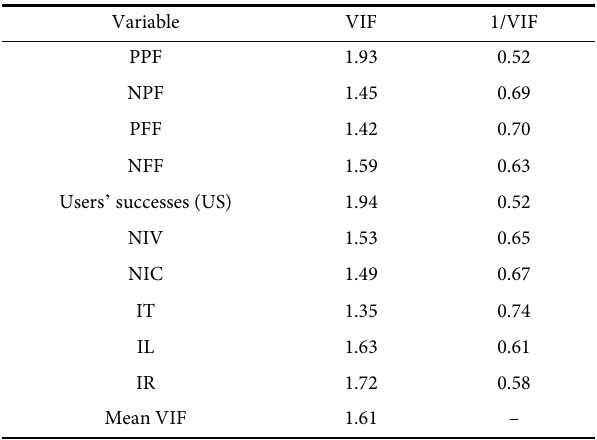
Table 3 Test for multicollinearity.